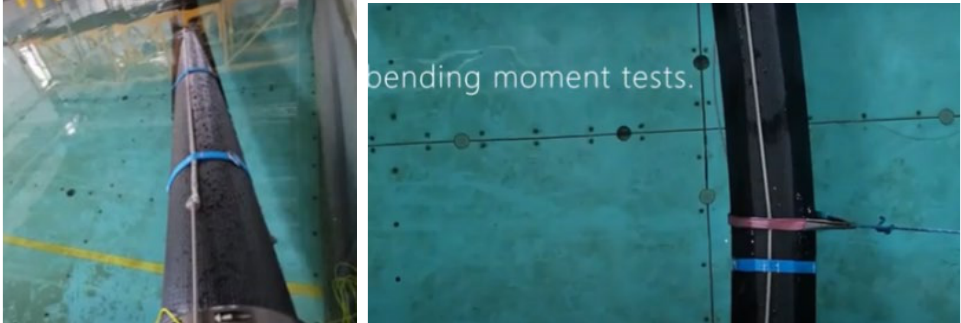
Figure 14. Seastrut TM under testing—https://impact-9.com/technology (accessed on 22 September 2022).